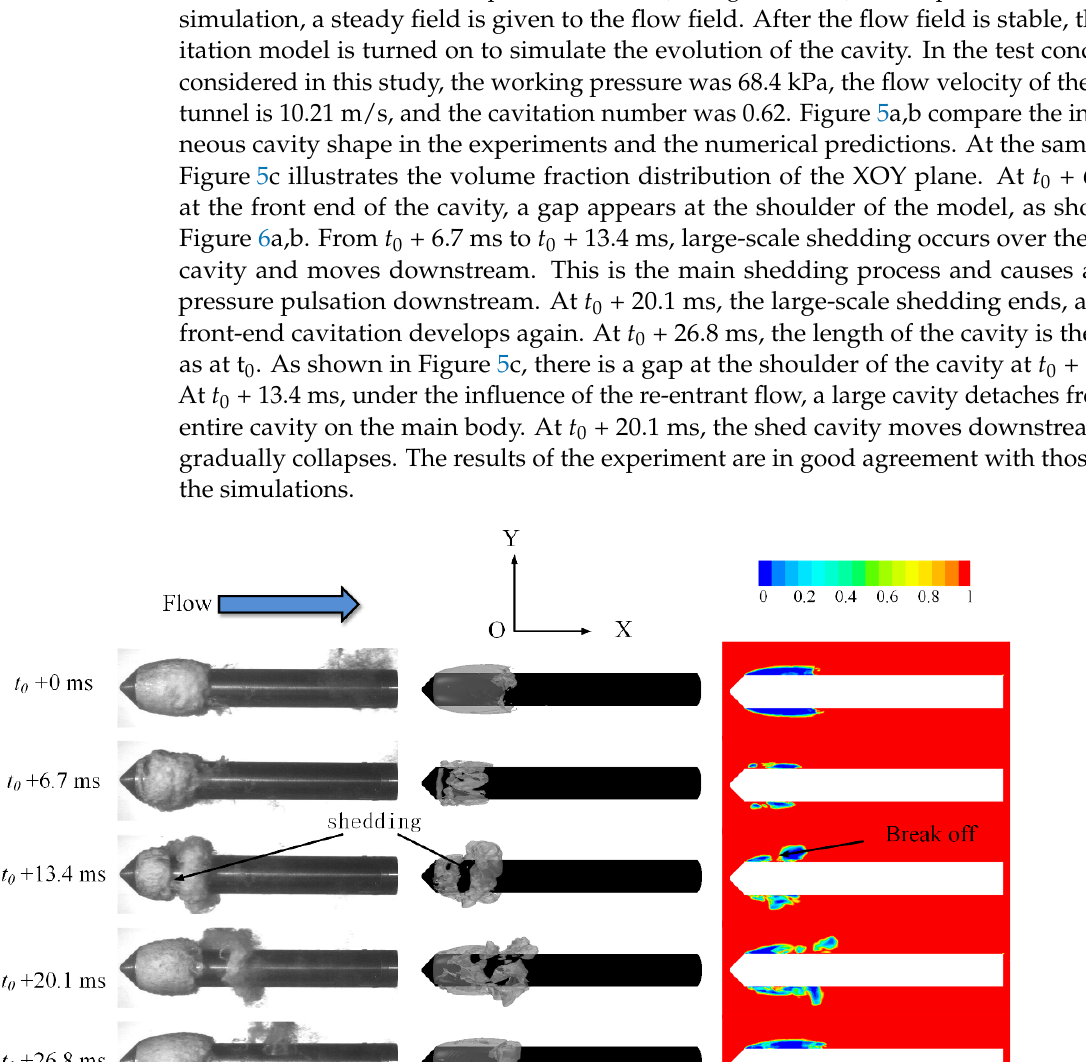
Figure 4. Mesh generation around the model.